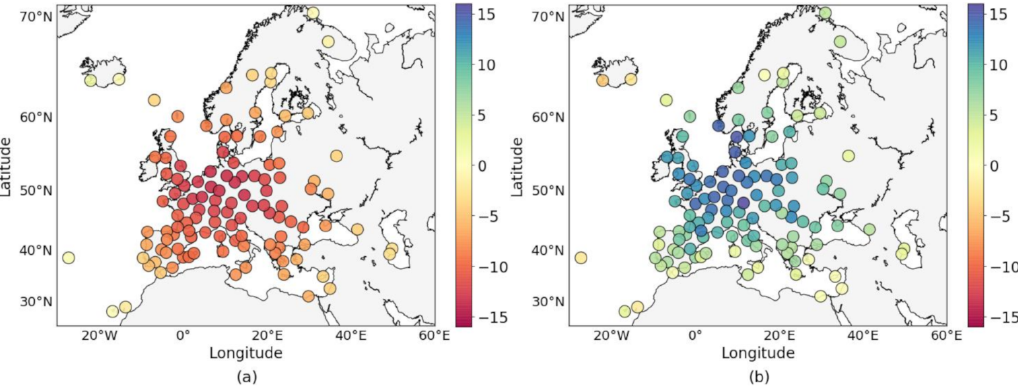
Figure 8. Spatial pattern coefficients describing the first single-value decomposition (SVD) of the residuals of the SP and of those of the Up coordinate. ( a ) SP spatial pattern; ( b ) Up spatial